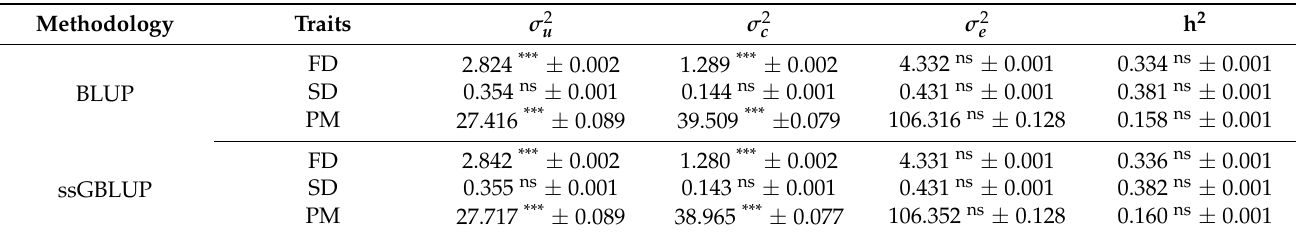
Table 2. Mean of variance components, heritabilities (h 2 ) ± standard error of 50 replicates estimated by BLUP and ssGBLUP methods, and significance of the differences in h 2 between methods for fiber diameter (FD), standard deviation (SD) and percentage of medullation (PM) in Huacaya